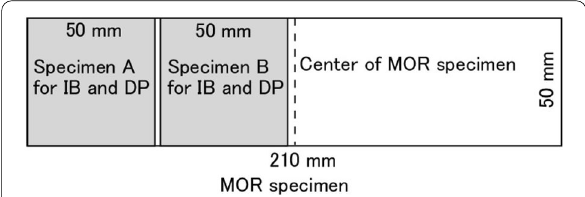
Fig. 1 Sampling positions of specimens A and B in the modulus of rupture (MOR) specimen. IB internal bond, DP density profile